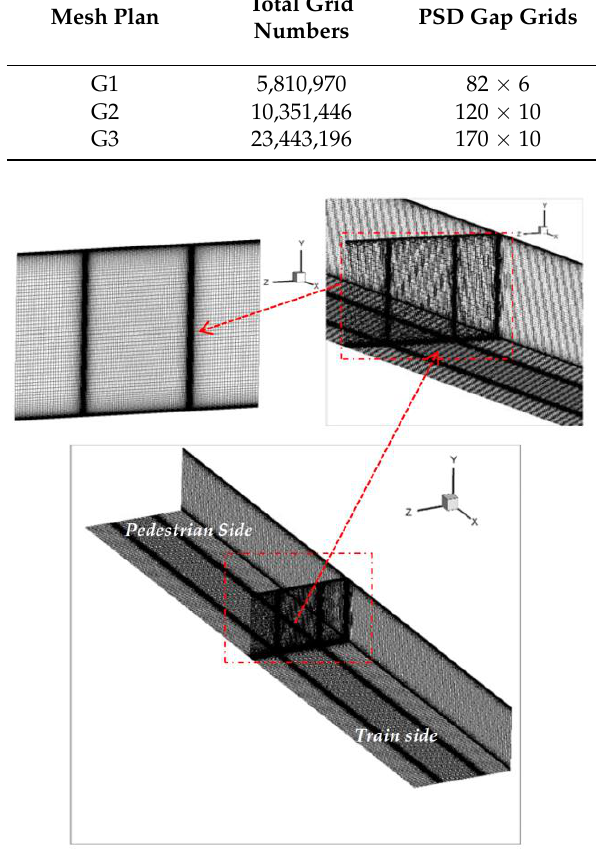
Figure 4. Mesh scheme details of numerical domain and PSD gaps.